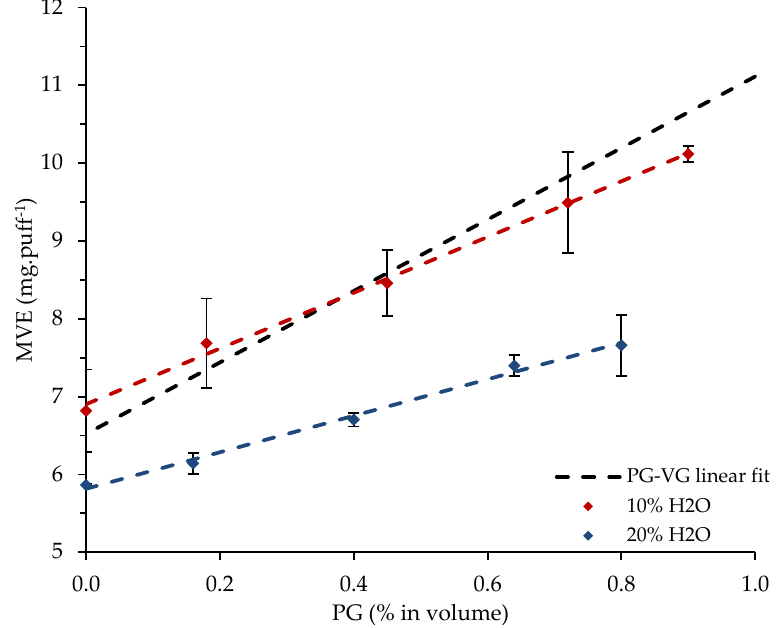
Figure 10. Influence of the PG volume fraction of {PG-VG}, {PG-VG-H 2 O (10%)}, and {PG-VG-H 2 O (20%)} mixtures on their MVE (measured at ambient temperature).